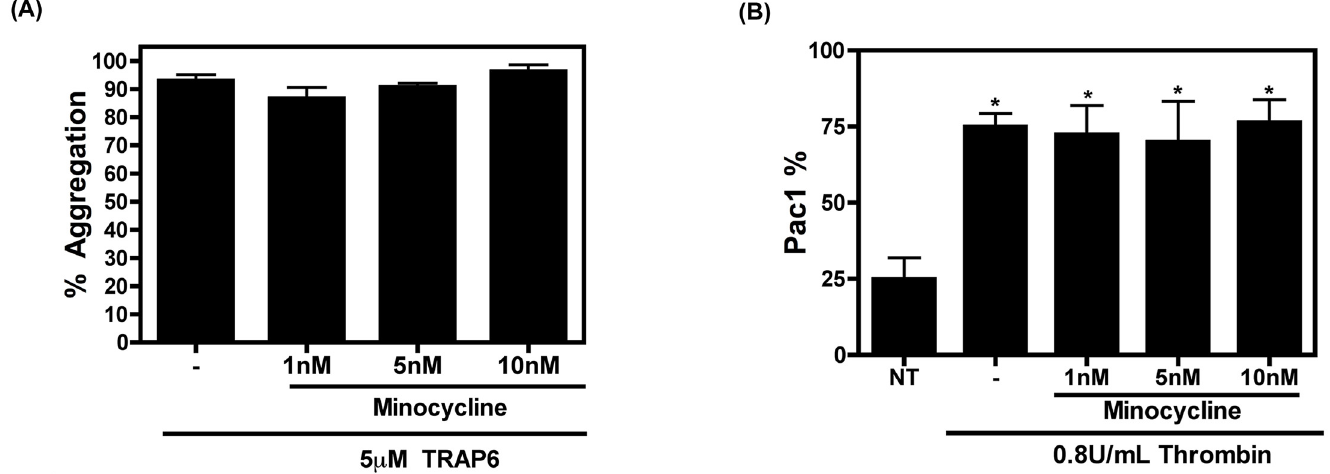
Fig 4. Minocycline does not affect aggregation or GPIIb/IIIa activity. (A) Platelet aggregation was measured in the presence of minocycline and TRAP 6. Percent (%) Aggregation was plotted and is representative of three separate experiments and was compared using a one way ANOVA statistical test followed by Bonferroni ’ s test for multiple comparisons. (B) Active GPIIb/IIIa was measured as the percentage of platelets staining positive for Pac-1 via flow cytometry. Data is representative of three separate experiments and compared using a one way ANOVA statistical test followed by Bonferroni ’ s test for multiple comparisons, where * denotes p < 0.05.